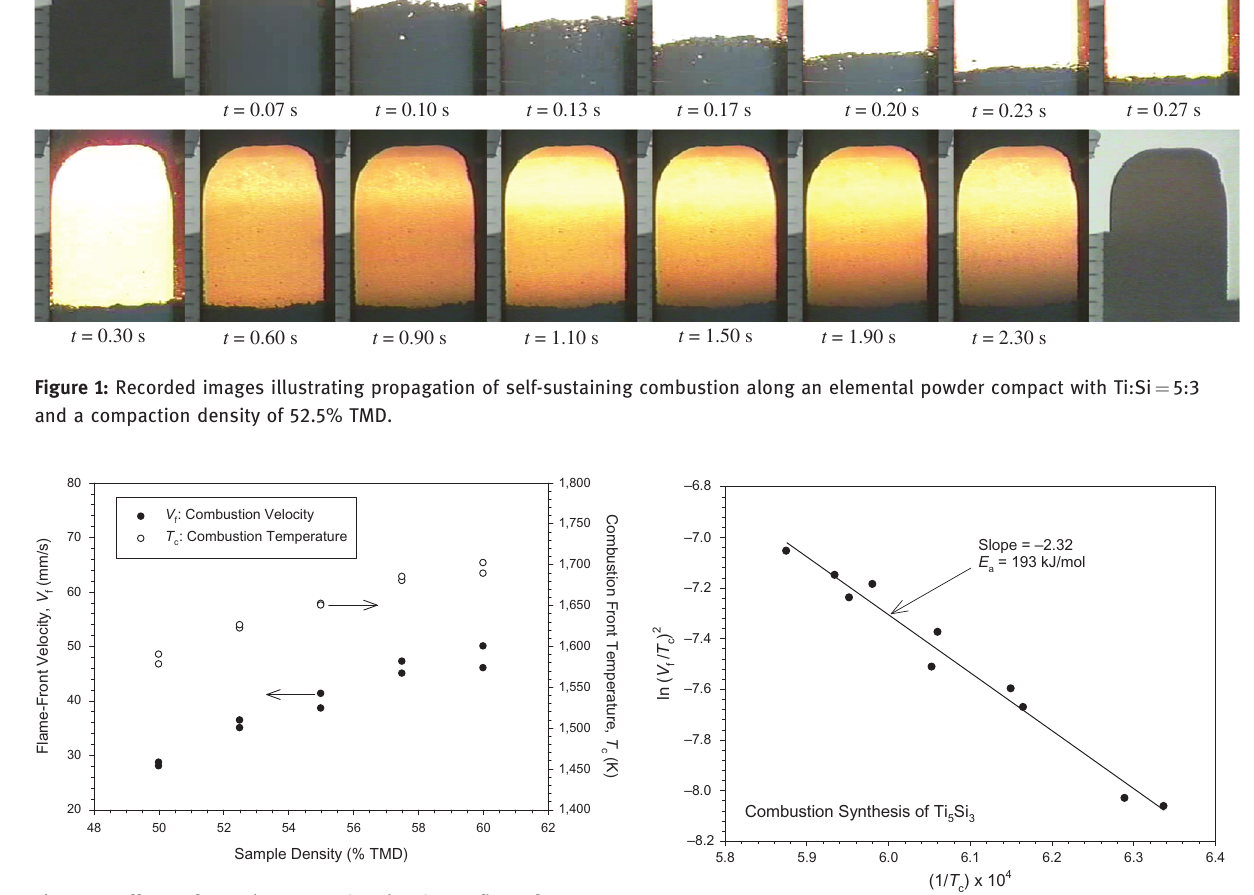
Figure 3: Relationship between combustion front velocity ( V f ) and temperature ( T c ) for determination of activation energy ( E a ) of combustion synthesis of Ti 5 Si 3